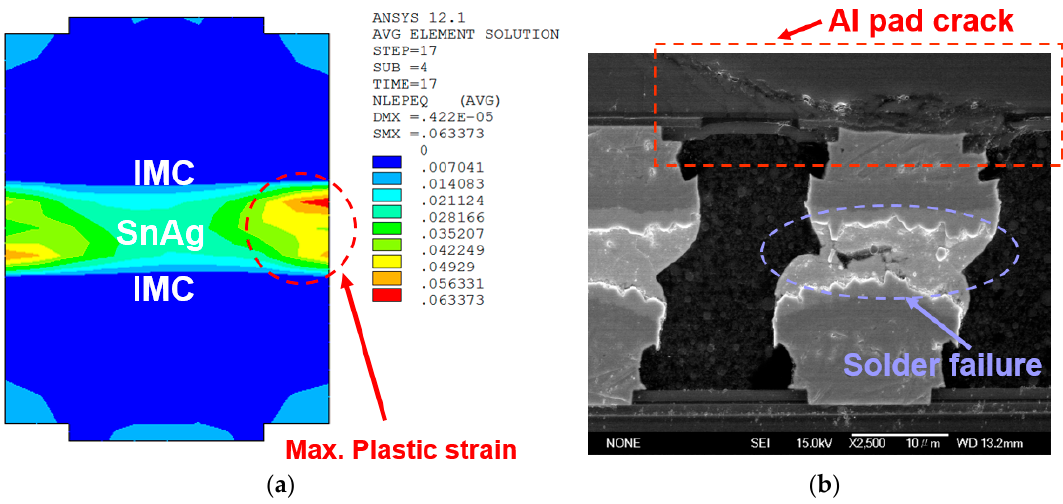
Figure 8. Comparison of the FEA and the experimental examination of four-chip stacked packaging in terms of failure mode: ( a ) Contour of the maximum equivalent plastic strain in the critical μ -joint; ( b ) Solder failure of the critical μ -joint after TCT [12].